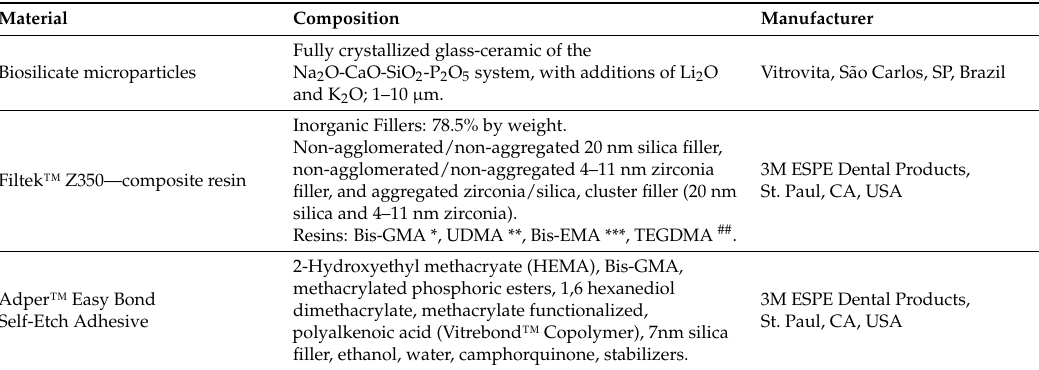
Table 1. Materials used in this